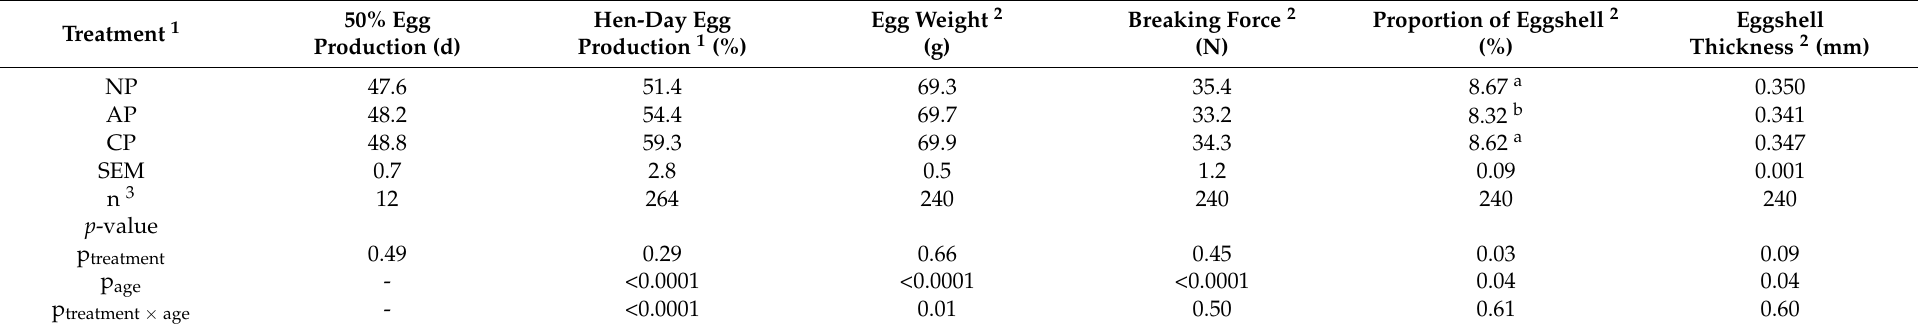
Table 5. The effects of cooled perches on egg production and eggshell traits of caged laying hens post-molt from 89–110 weeks of